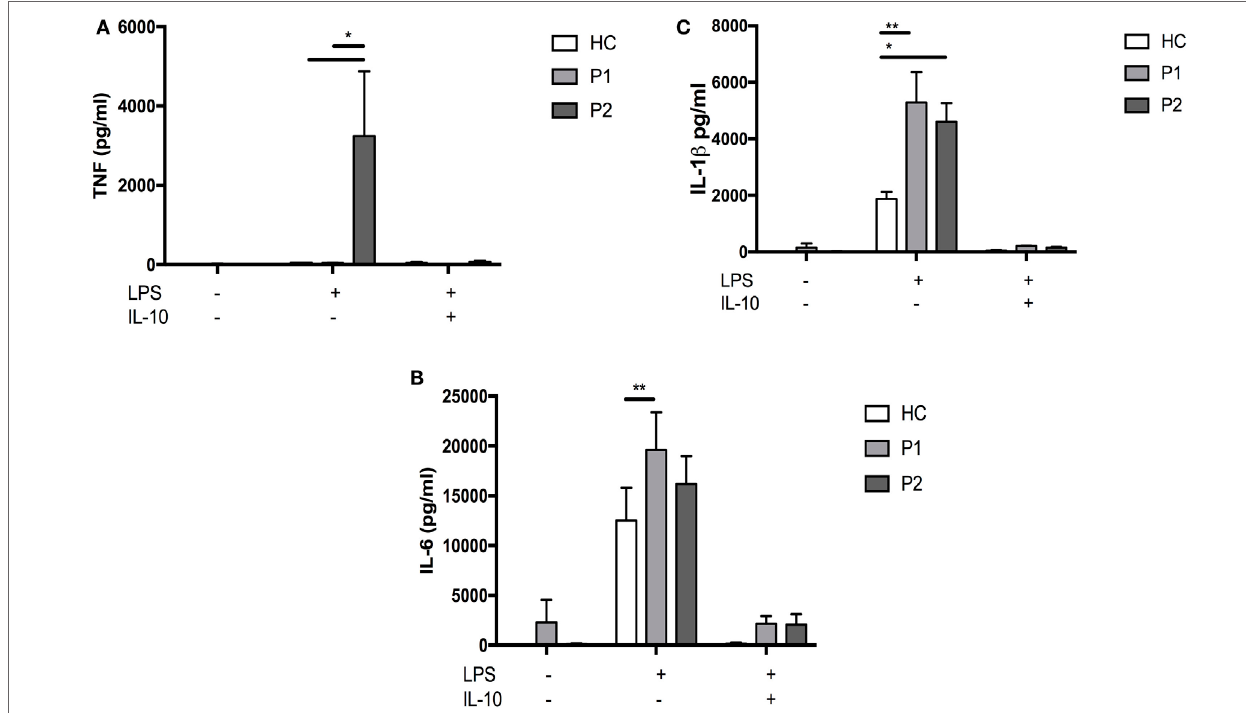
FIGURe 2 | Whole blood lipopolysaccharide (LPS) stimulation and cytokine responses. Whole blood was diluted 1:5 with Roswell Park Memorial Institute medium into 96-well F plates (Corning) and activated by single stimulation or co-stimulations as indicated with LPS (1 µg/mL; List Biochemicals), + others. Supernatants were taken at 24 h. Cytokines were measured with multiplexed particle based flow cytometry (a) TNFa (B) IL6 (C) IL-1 β ; (All measured with R+D Systems Fluorokinemap) on a Luminex analyzer (Bio-Plex, Bio-Rad, UK). Two-way ANOVA statistical test was used ( p <